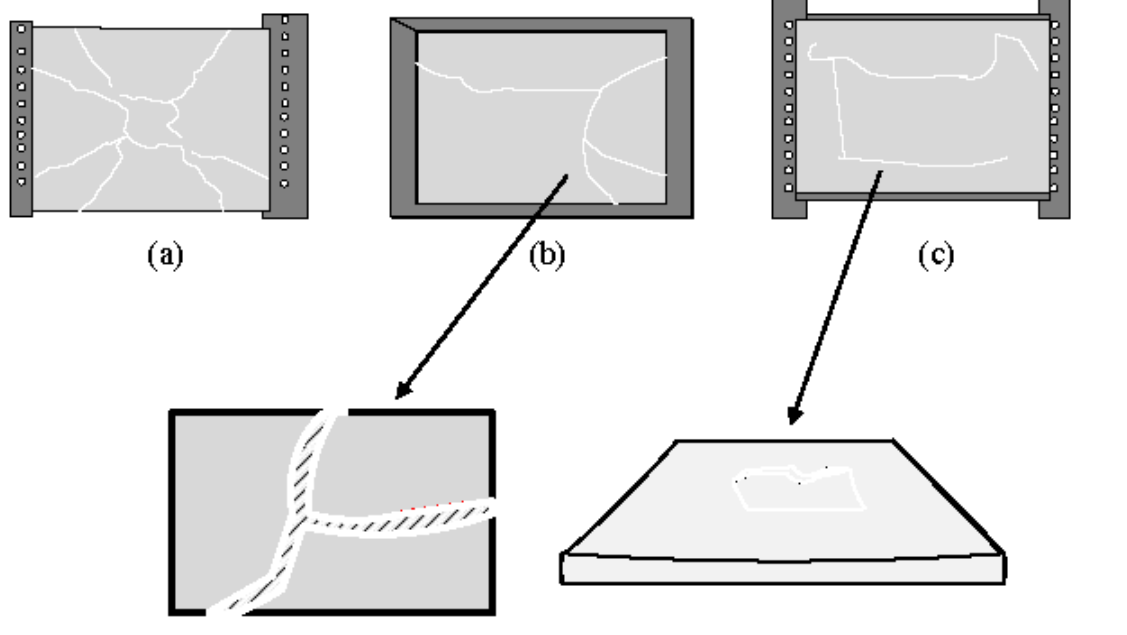
Figure 26. FMs in unstrengthened and strengthened slabs with different textile layers [117]: ( a ) unstrengthened slab failed by flexural cracks; ( b ) strengthened slab failed by partial rupture and slippage within the mortar layer; ( c ) strengthened slab with partial fiber slippage within the matrix across two cracks, followed by the concrete punching shear.